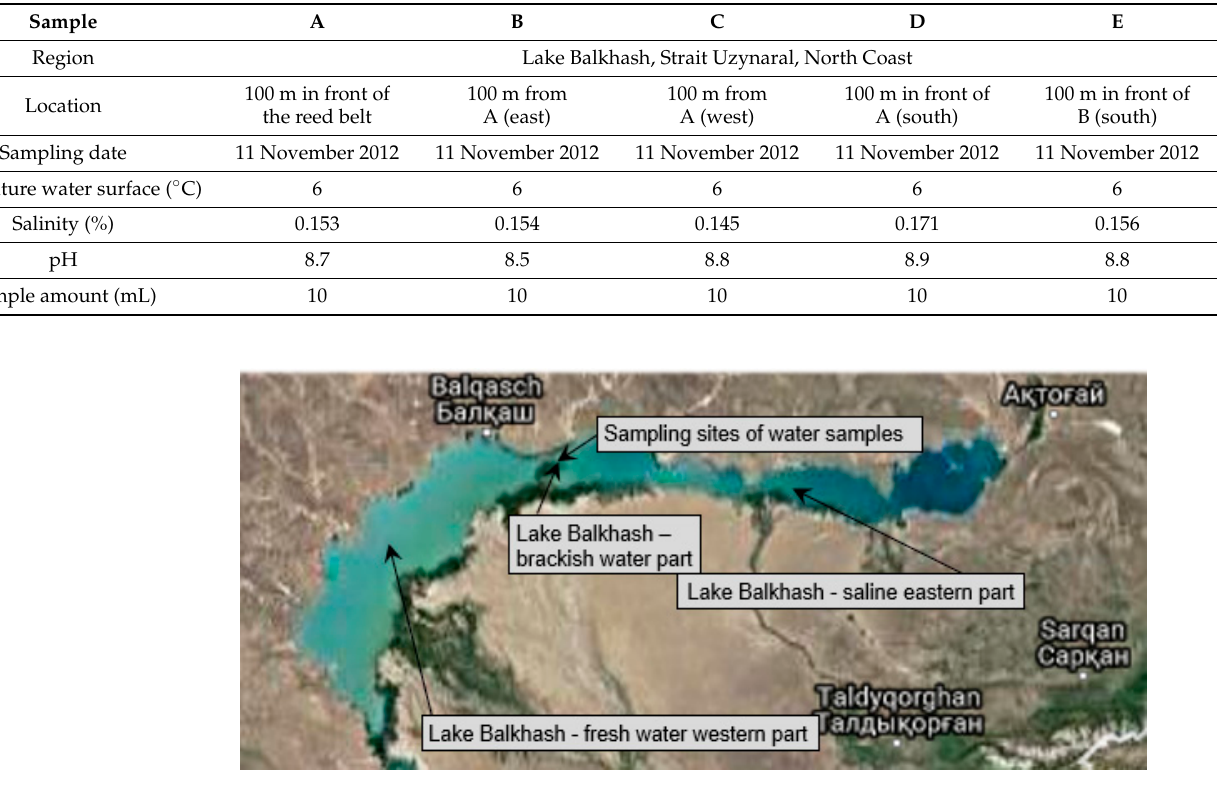
Figure 1. Sampling site of water samples A–E from Strait Uzynaral, Lake Balkhash (Kazakhstan). Strait Uzynaral separates the fresh water western part of the lake from the saline eastern part. It is a brackish water habitat with a salinity between 0.15% and 0.17% at the sampling site. As expected, the “eastern” samples had a higher salinity than the “western” samples, and the salinity was also higher 200 m in front of the reed belt than at a distance of only 100 m. The 10 mL water samples were filled into sterile falcon tubes and processed under sterile conditions on the same day according to Section 2.5.1.